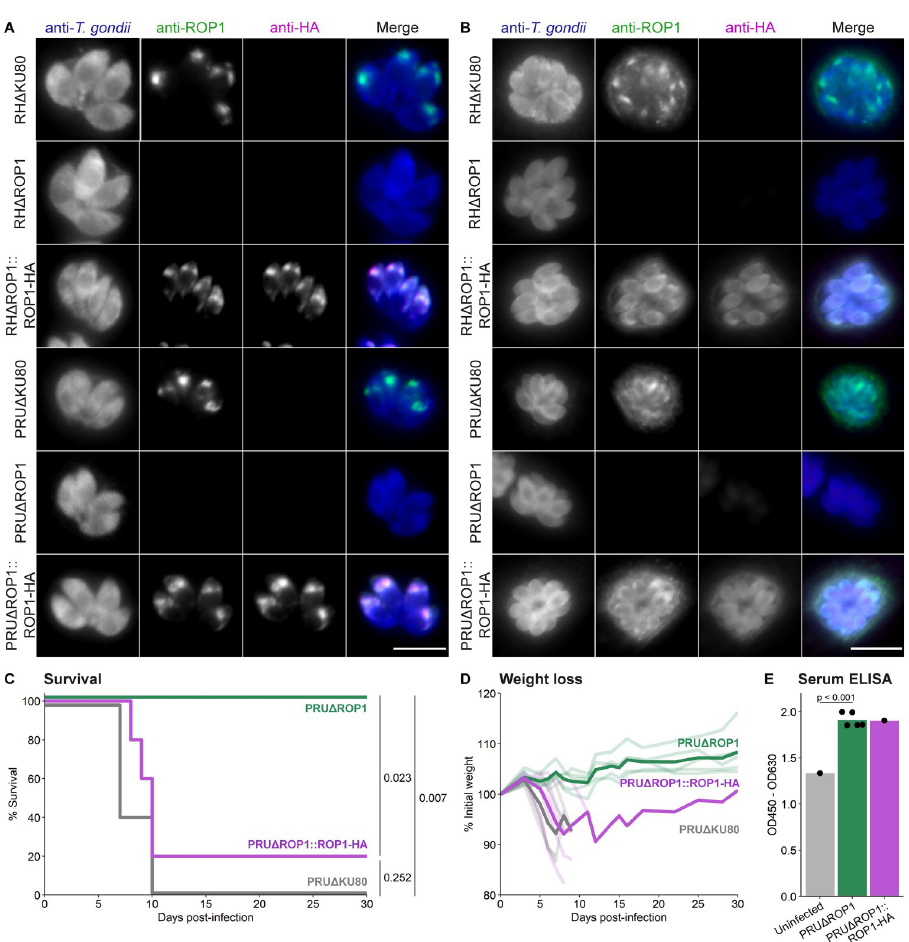
Fig 2. PRU Δ ROP1 parasites are avirulent in vivo . A, B. Immunofluorescence verification of ROP1 knockout and complemented T . gondii cell lines using A 15 minute permeabilisation or B 1 minute permeabilisation. Scale bar = 10 μ m. C. C57BL/6J mice were infected with 20,000 parasites each by intraperitoneal injection and survival was monitored for 30 days. p-values were calculated by log-rank test with Benjamini-Hochberg adjustment; n = 5 mice per group. D. Weight loss of infected mice as a percentage of initial weight. Individual mice are shown as pale lines; dark lines represent mean weight loss of surviving mice. E. Serum ELISA of mice surviving at 30 days post-infection against T . gondii tachyzoite lysate